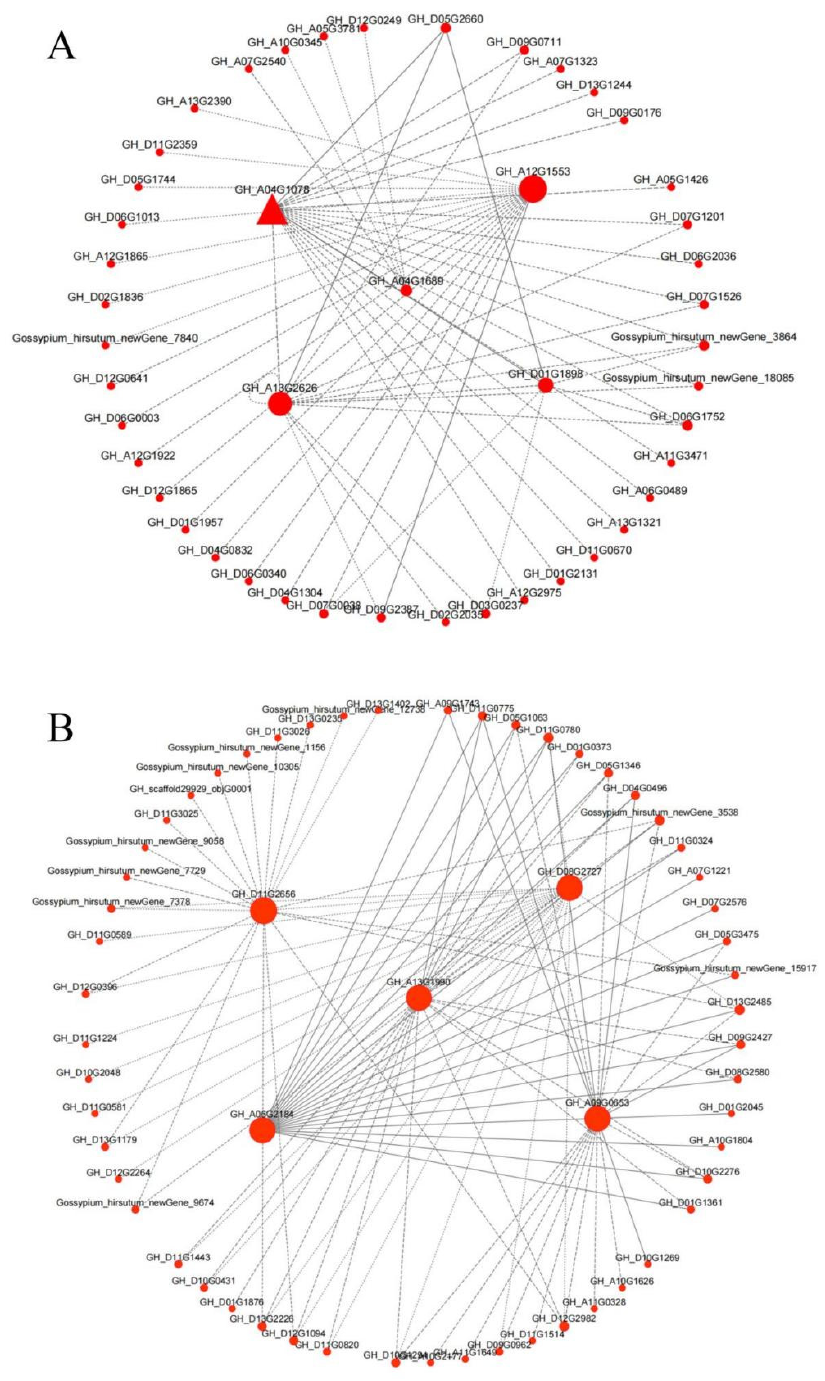
Figure 18. Gene co-expression network and hub genes in ( A ) MEred and ( B ) MEyellow